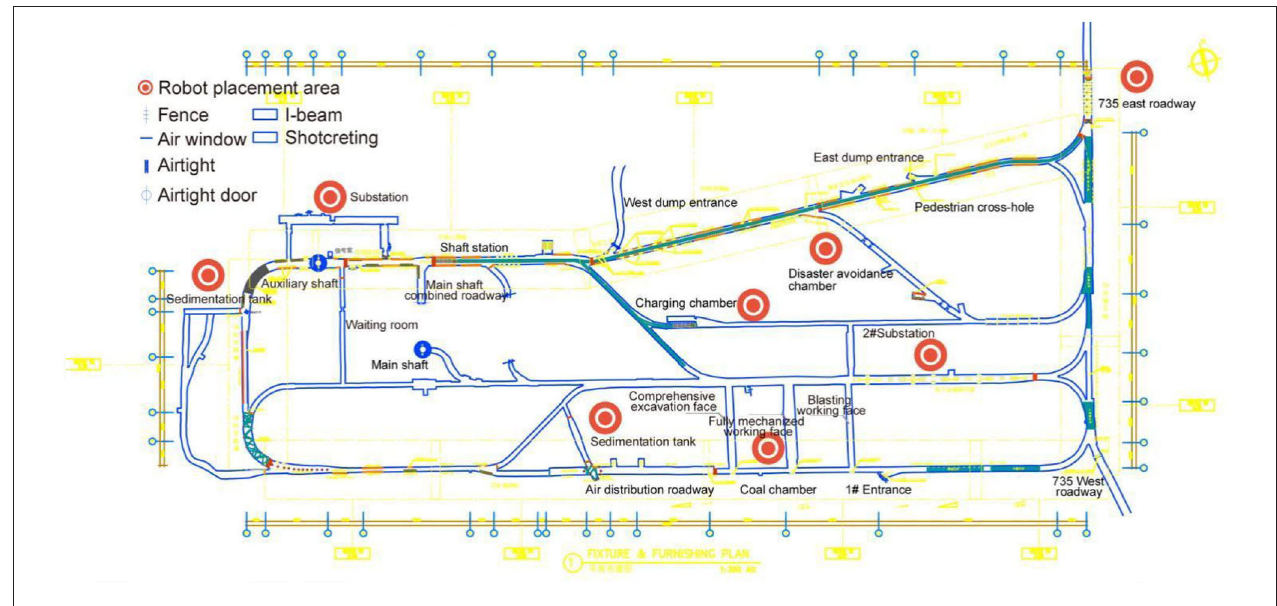
FIGURE 11 | The diagram of inspection system distribution.